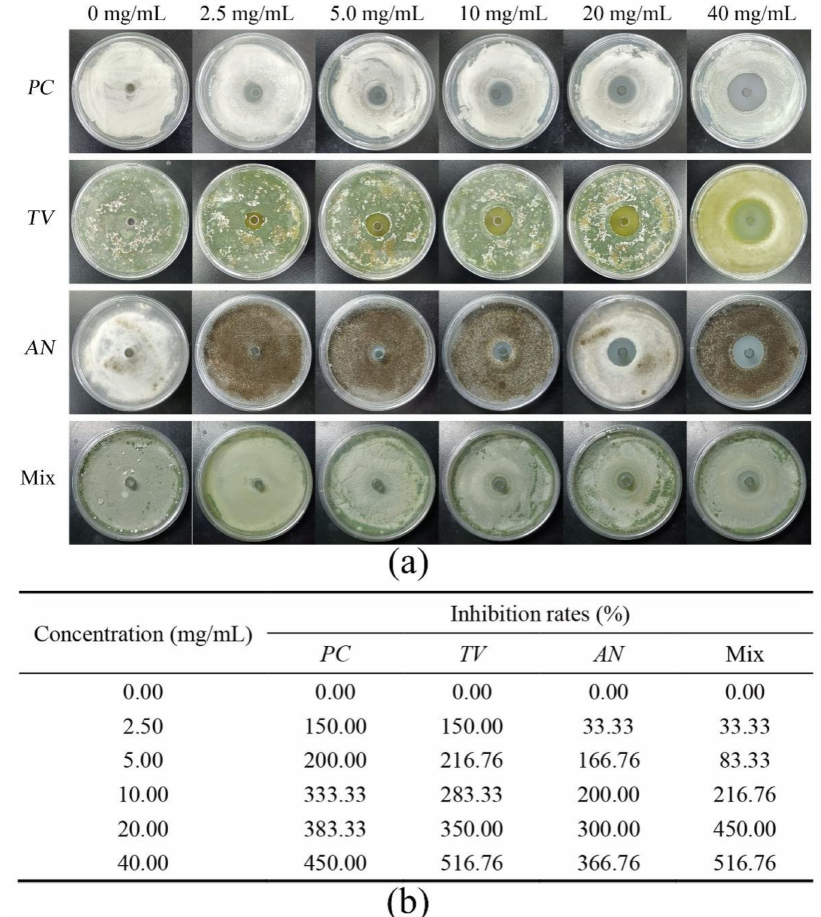
Figure 3. Results of inhibition zone and inhibition rate of different dodecylpyridinium chloride concentrations against bamboo mildew. ( a ) Inhibition zone results; ( b ) inhibition